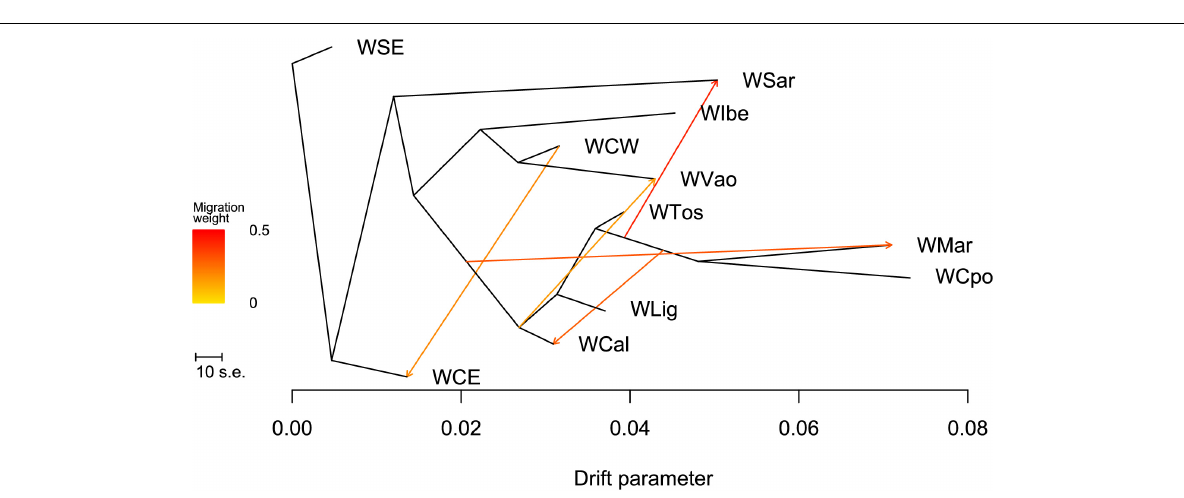
FIGURE 6 | Maximum likelihood tree obtained with TREEMIX describing the relationships among the analyzed wild boar populations sampled in Italy and in the rest of